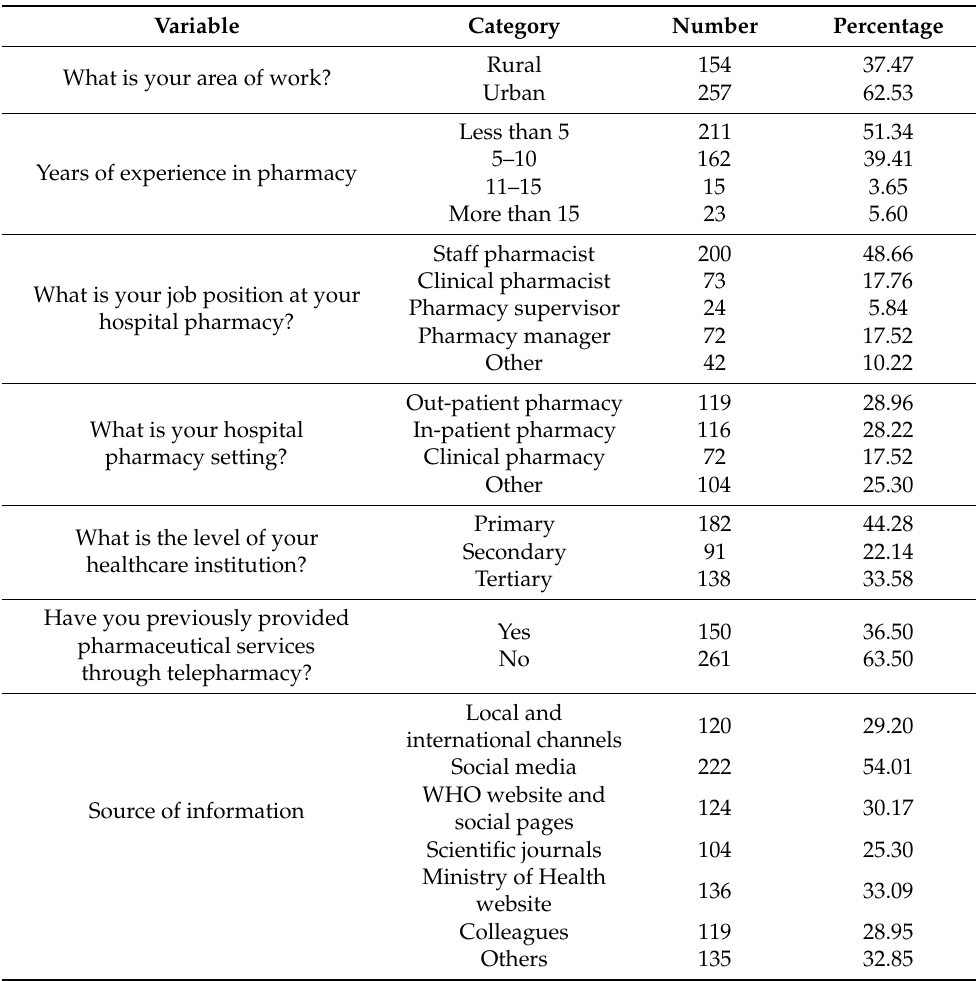
Table 2. Employment data of the respondents (n = 411).